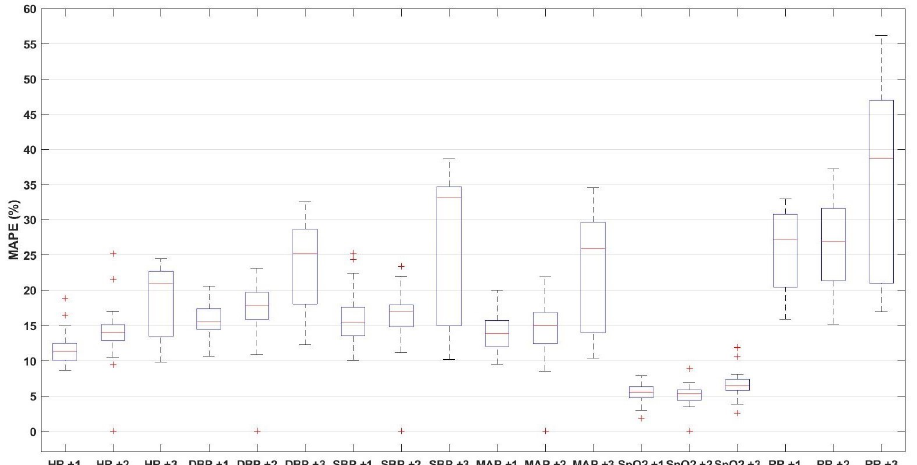
Figure 3. The box-plot of leave-one-subject-out predictions of the vital signs of heart rate (HR), diastolic (DBP), systolic (SBP), mean arterial blood pressure (MAP), oxygen saturation (SpO 2 ), and respiration rate (RR) for the upcoming three observations (on average 3 h